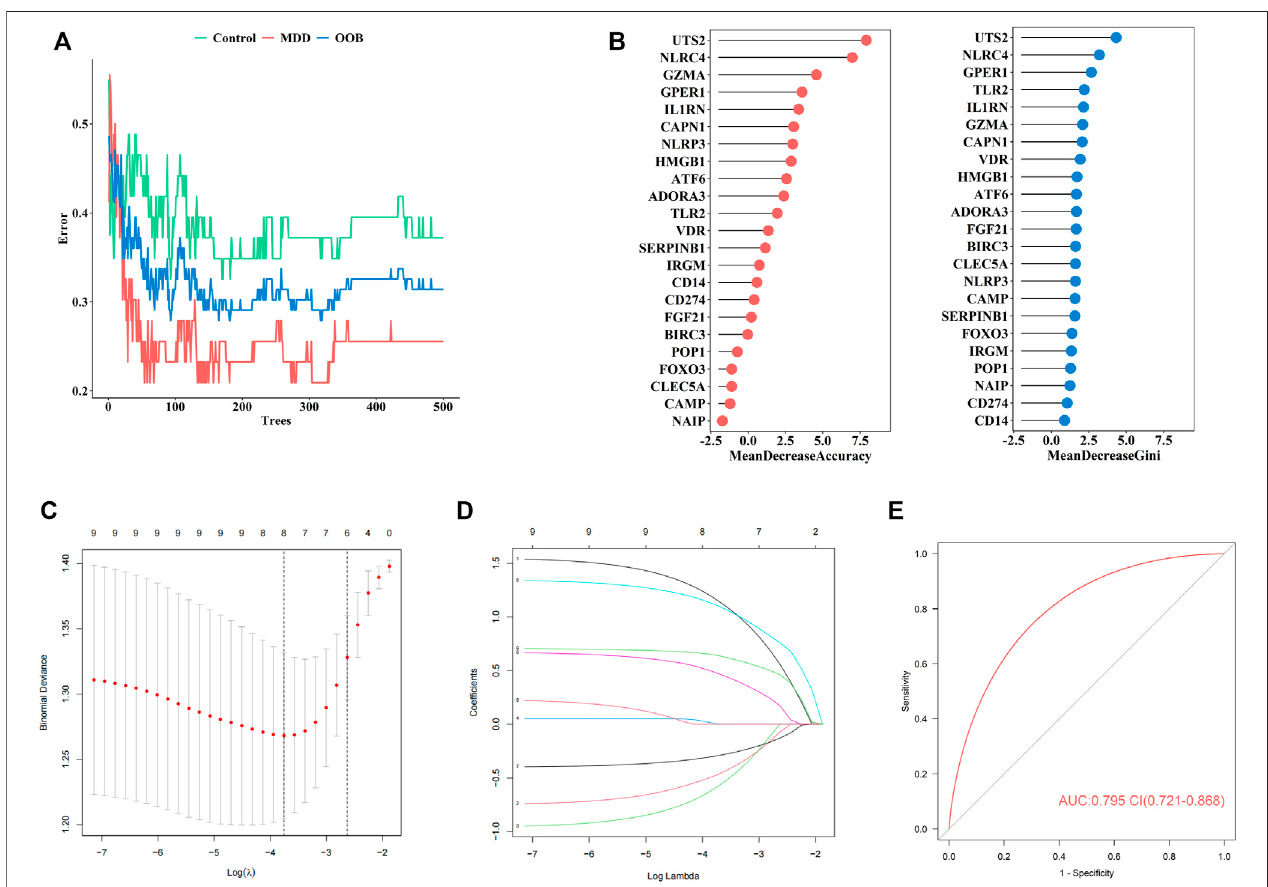
FIGURE 3 | The construction of our diagnostic model for MDD (A) . Error between the number of decision trees and different groups (B) . The MeanDecreaseAccuracyandMeanDecreaseGiniof23pyroptosis-relatedgenes (C) .Screeningoftheoptimalparameter(usinglambda.1seasthebestlambda)atwhich the vertical lines were drawn (D) . LASSO coef fi cient pro fi les of the 23 differentially expressed PS genes plus age and sex (E) . The ROC value of our diagnostic model in GSE98793 dataset.